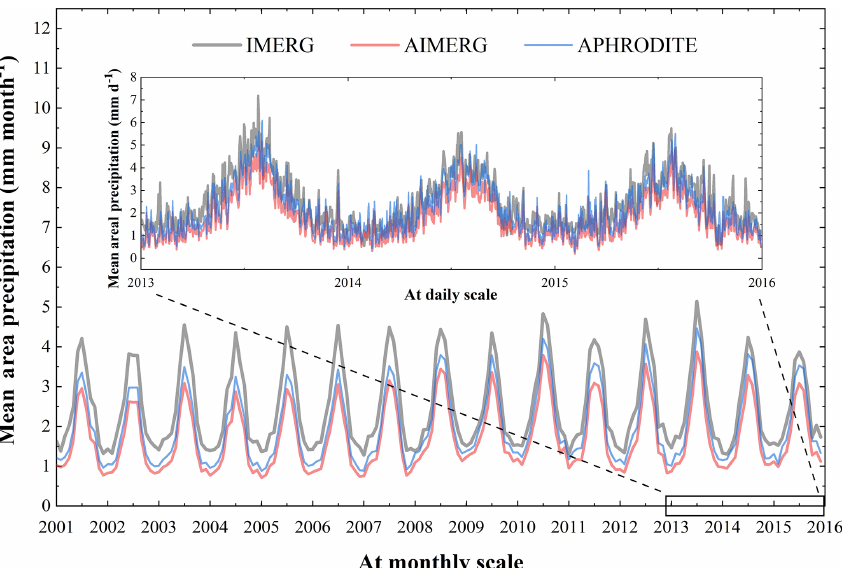
Figure 3. The temporal variations of mean Asian gridded precipitation products of IMERG, APHRODITE, and AIMERG, respectively, during the period of 2001–2015.